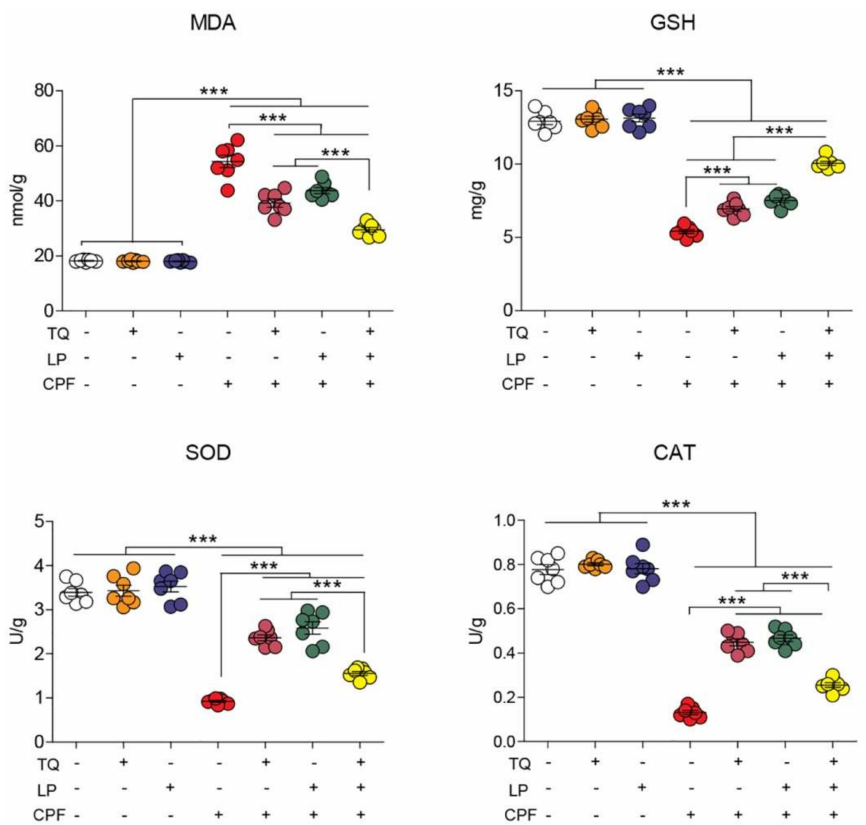
Figure 2. Dot plot of oxidative/antioxidative status after treatment with CPF, TQ, and LP. CAT, catalase; CPF, chlorpyrifos; GSH, reduced glutathione; LP, lycopene; MDA, malondialdehyde; SOD, superoxide dismutase; TQ, thymoquinone. Values are proffered as the mean ± SE ( n = 7). *** p ≤